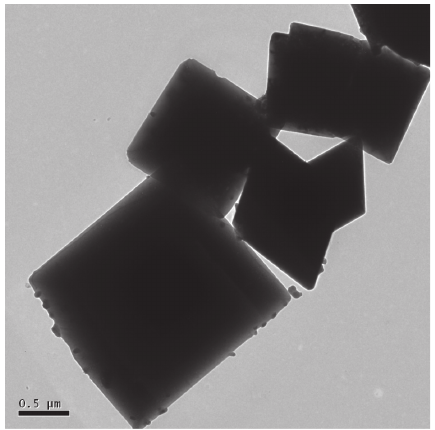
Figure 2: TEM images of YVO through hydrothermal